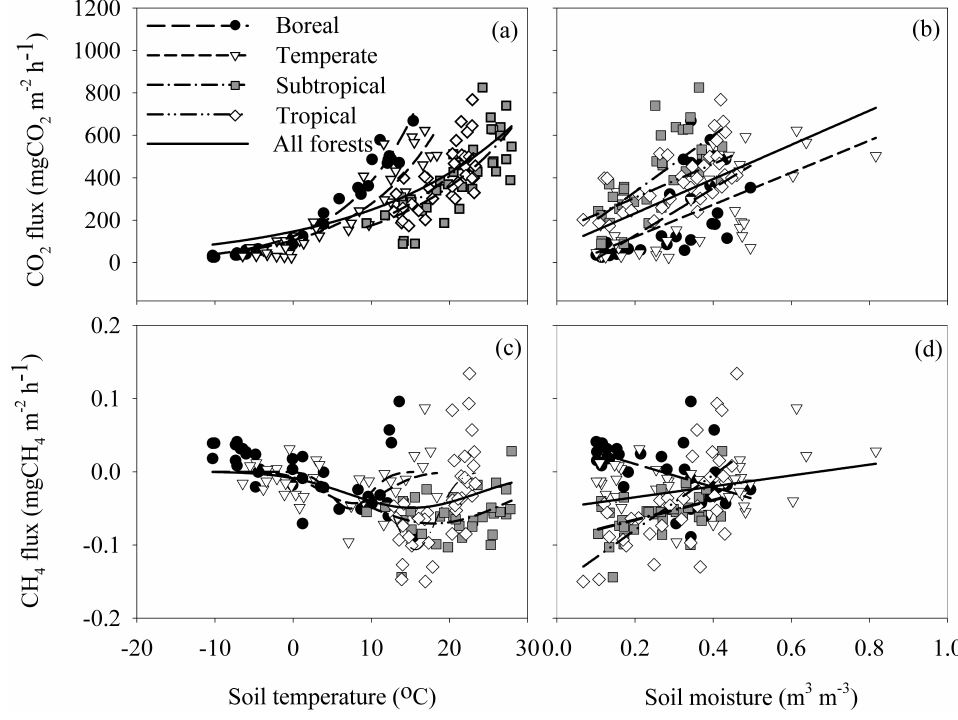
Fig. 5. Relationships of CO 2 and CH 4 fluxes to soil temperature and moisture at a depth of 10cm in the four forests.